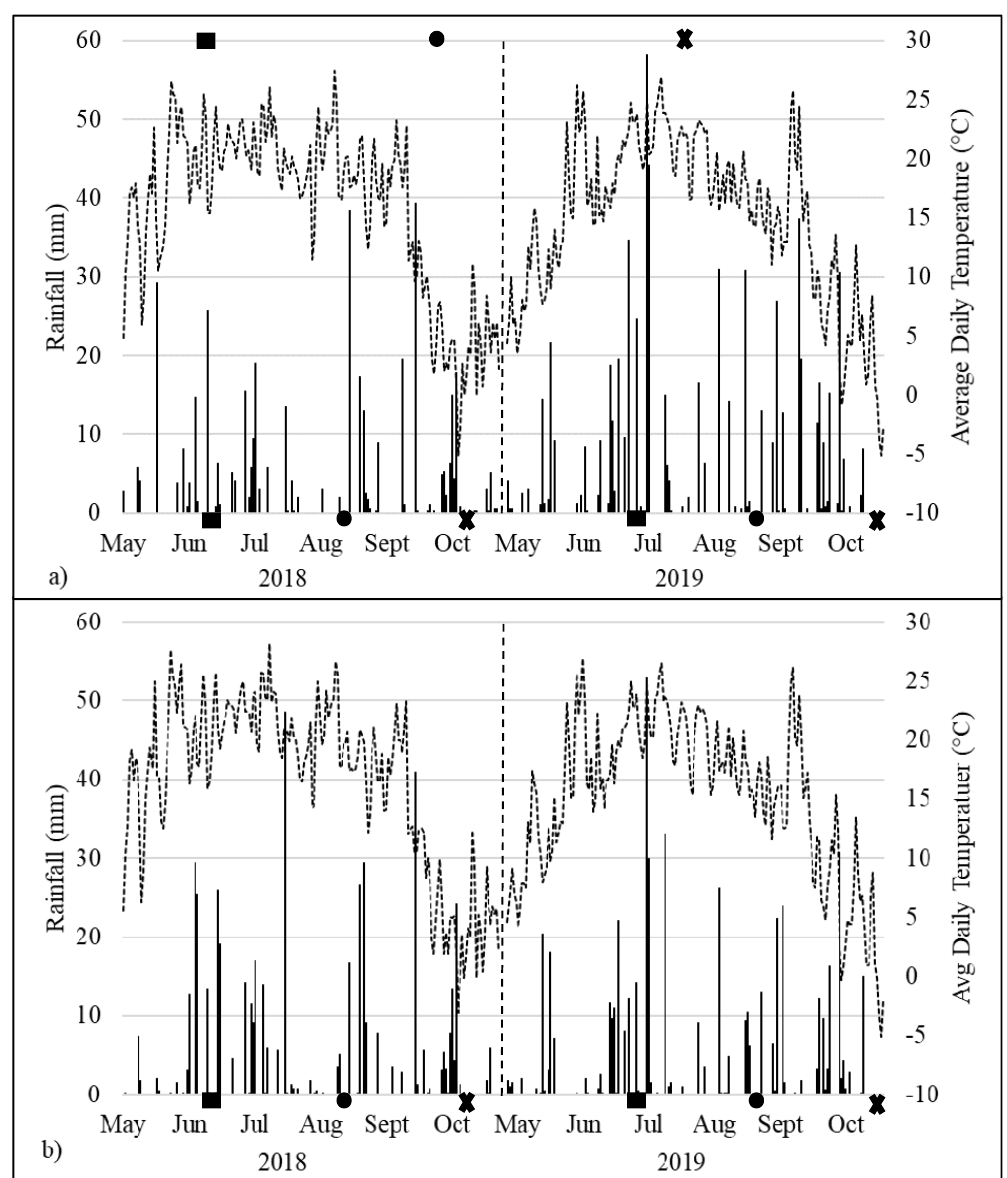
Figure 1. Average daily temperature (dashed line) and daily rainfall (solid bars) at ( a ) Prosper, ND, and ( b ) Sabin, MN, weather stations from 1 May to 31 October 2018 and 1 May to 31 October 2019.